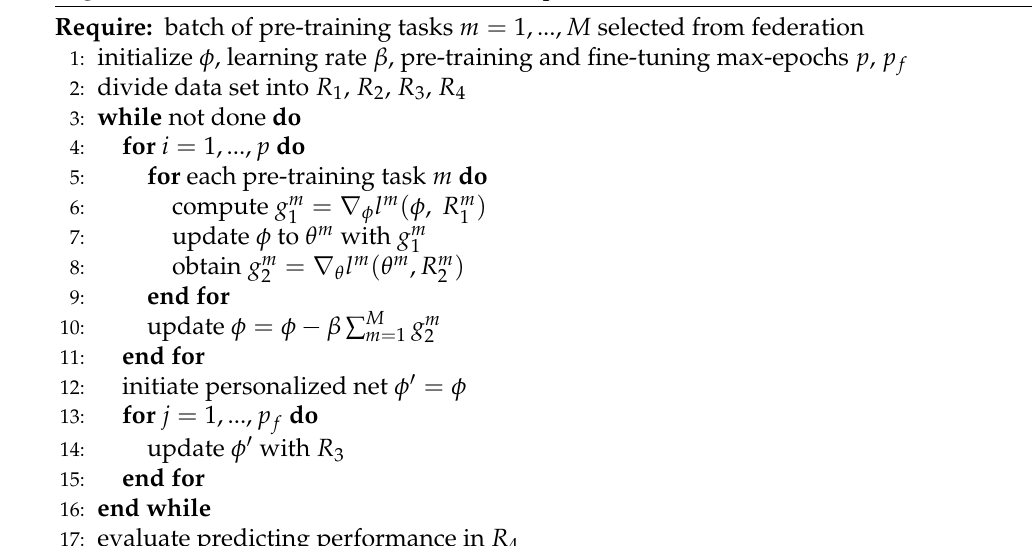
Algorithm 1 Meta-Learner: FedFOMAML—pseudocode.